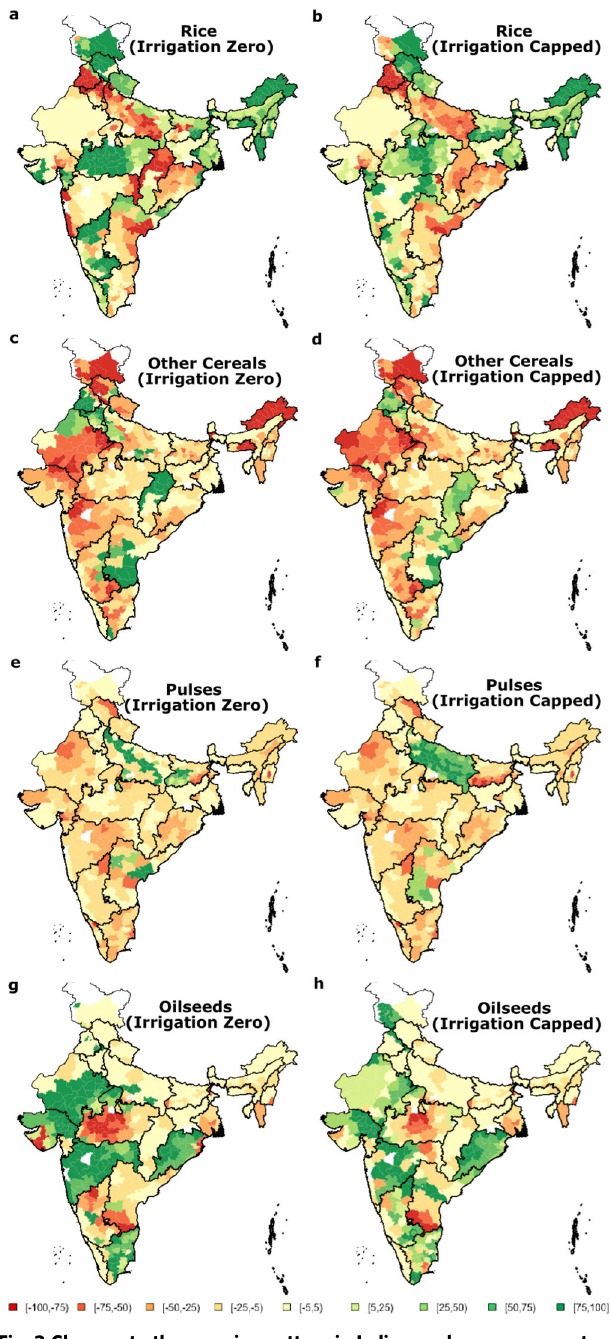
increase or decrease relative to the current cropped area in Kharif season under the two proposed scenarios. a , b rice under the “ Irrigation Zero ” and “ Irrigation Capped ” scenarios. c , d other cereals under the “ Irrigation Zero ” and “ Irrigation Capped ” scenarios. e , f pulses under the “ Irrigation Zero ” and “ Irrigation Capped ” scenarios. g , h oilseeds under the “ Irrigation Zero ” and “ Irrigation Capped ” scenarios.